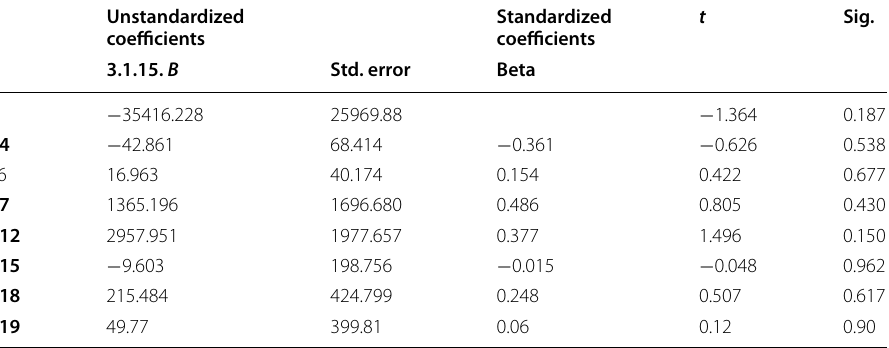
Table 10 Regression results for factor 2 variables